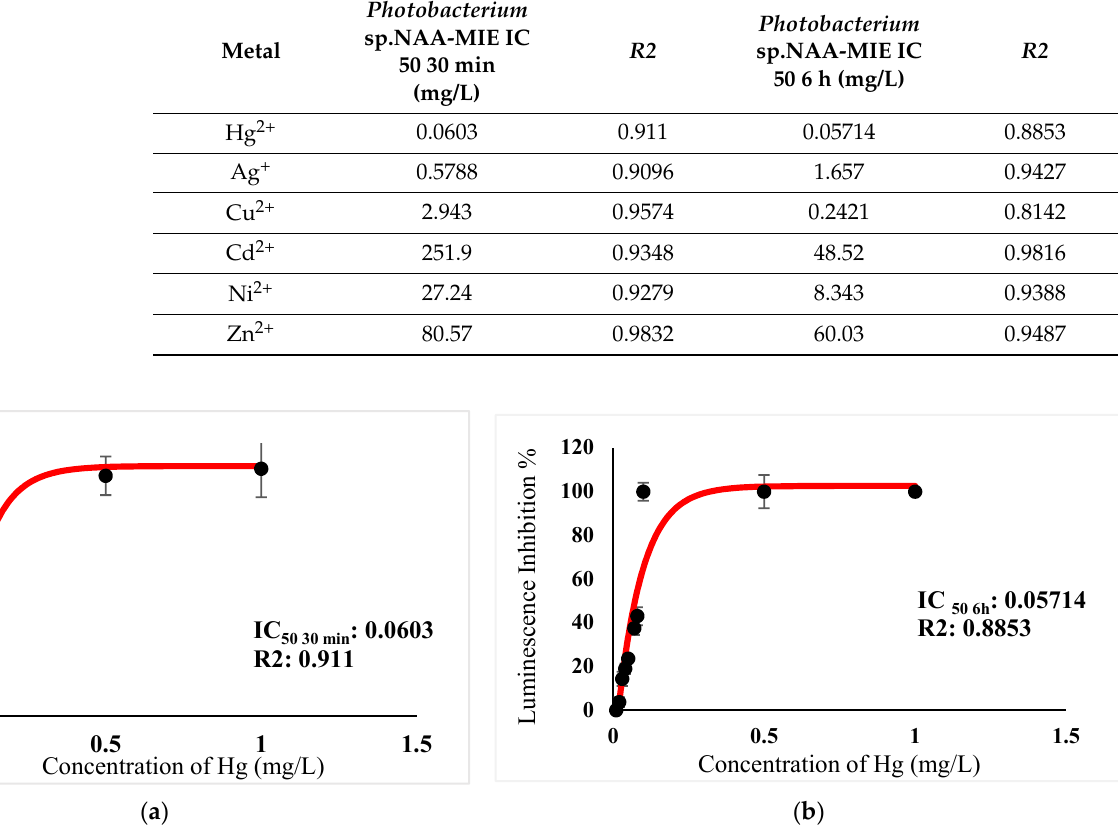
Figure 2. ( a ) Acute and ( b ) Chronic toxicity of Hg 2 on luminescence inhibition of Photobacterium sp.NAA-MIE. Data represent mean ± SD, n = 3.